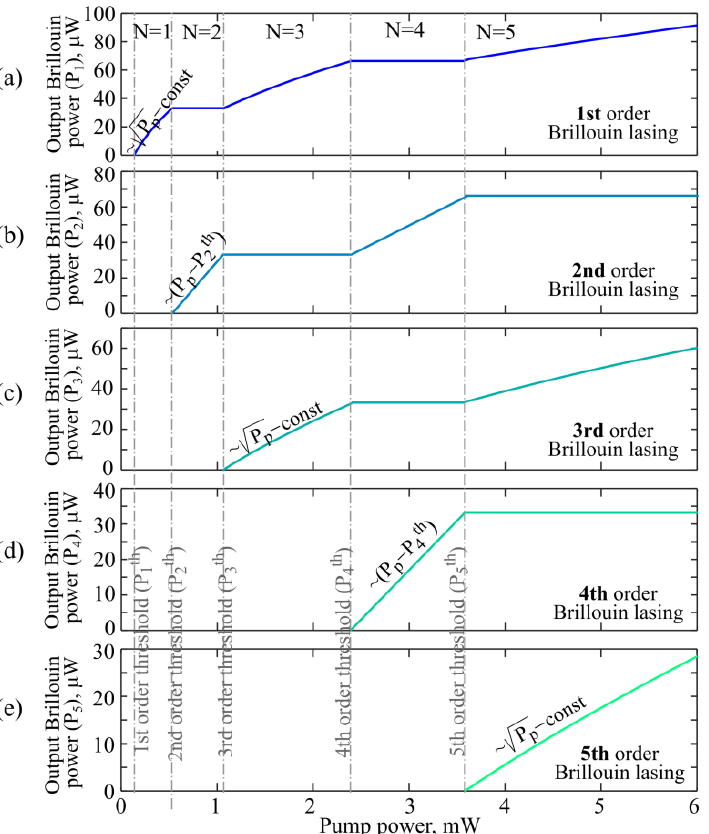
Figure 10. Theoretically calculated output powers of generated Stokes–Brillouin waves of the 1st order ( a ), 2nd order ( b ); 3rd order ( c ); 4th order ( d ); and 5th order ( e ) as functions of pump power for zero detuning (Δω 0 = 0) and loaded Q-factors Q = 2.5 × 10 7 .